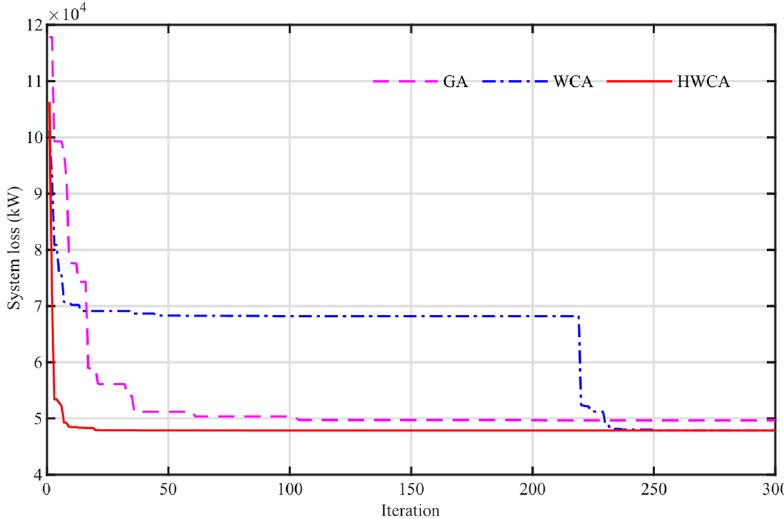
Figure 12. Convergence curve of the IEEE 69-node system using compared algorithms for case